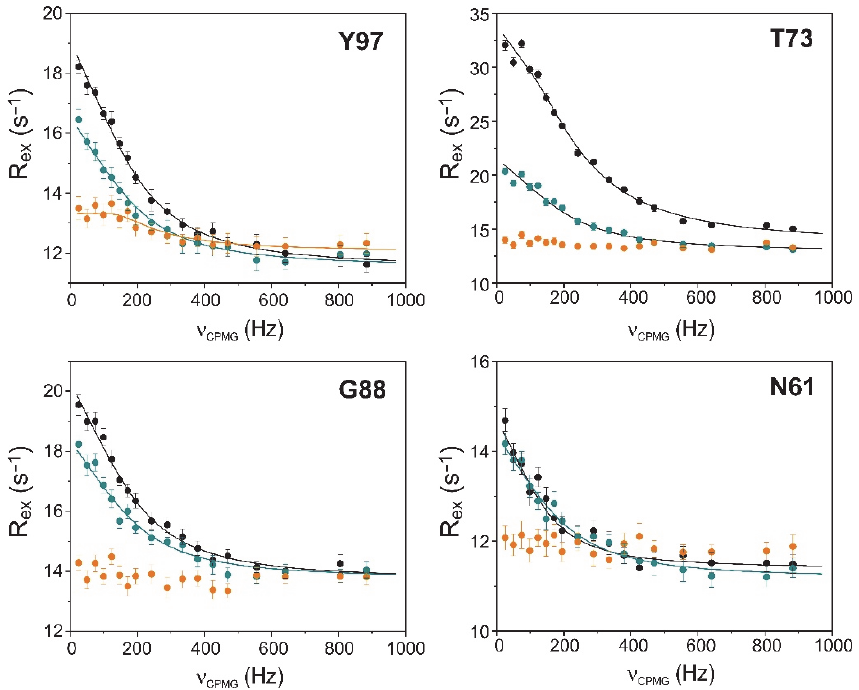
Figure 6. Transverse relaxation dispersions of the backbone 15 N nuclei of selected amino acid positions in wild-type (black), Q51A (orange), and Q99A (green) apo human I-BABP as a function of CPMG B 1 field strength. The experiments were performed at 283 K at a static magnetic field of 14.1 T. Error bars are standard deviations derived from duplicate measurements. Solid lines correspond to global two-state exchange models with parameters listed in Table 2. Table 2. Kinetic and thermodynamic parameters of conformational exchange in the investigated human I-BABP mutants deduced from 15 N backbone relaxation dispersion NMR measurements. Parameters obtained previously for WT are given in the footnote. Physical quantities are